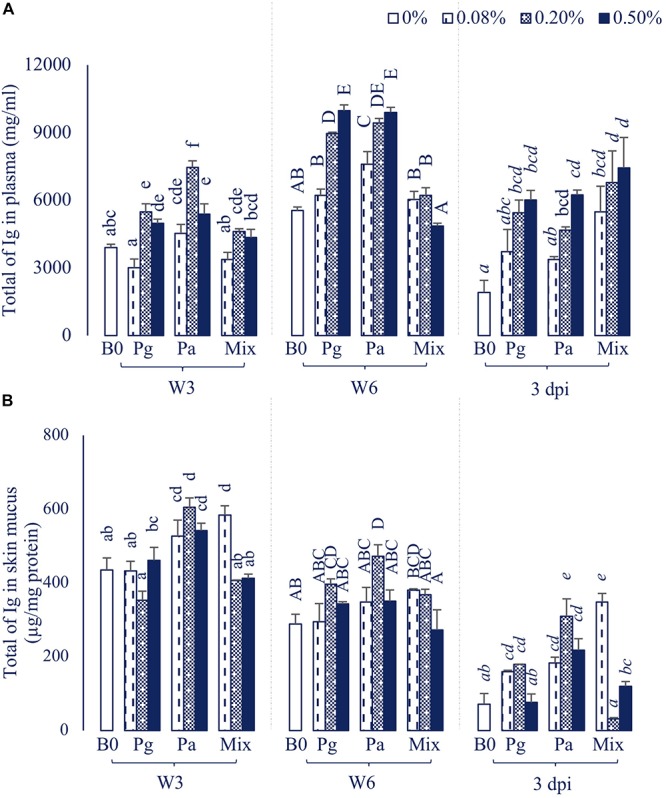
Total of Ig in (A) Plasma and (B) Skin mucus of striped catfish fed extract-based diets supplemented with a single supply or a mixture of P. guajava and P. amarus at 0; 0.08; 0.2; and 0.5% after 3, 6 weeks and 3 dpi. B0, basal diet; Pg, P. guajava; Pa, P. amarus; Mix, mixture of P. guajava and P. amarus; W3, week 3; W6, week 6; 3 dpi, 3 days post injection with E. ictaluri. Different letters indicate differences among diets at a given time point (p < 0.05). Values are means ± SEM, n = 3.